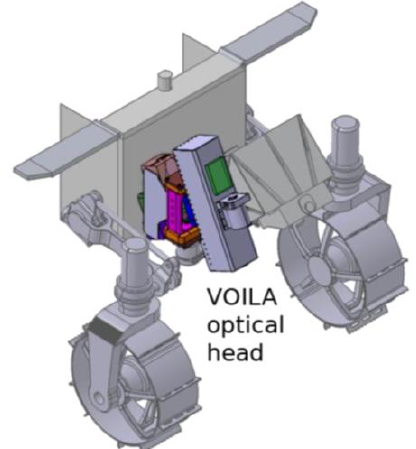
Figure 1. CAD model of the accommodation of the VOILA optical head at the front of the LUVMI-X rover. It can be tilted to the left and right, enabling the sampling of several positions to the front of the